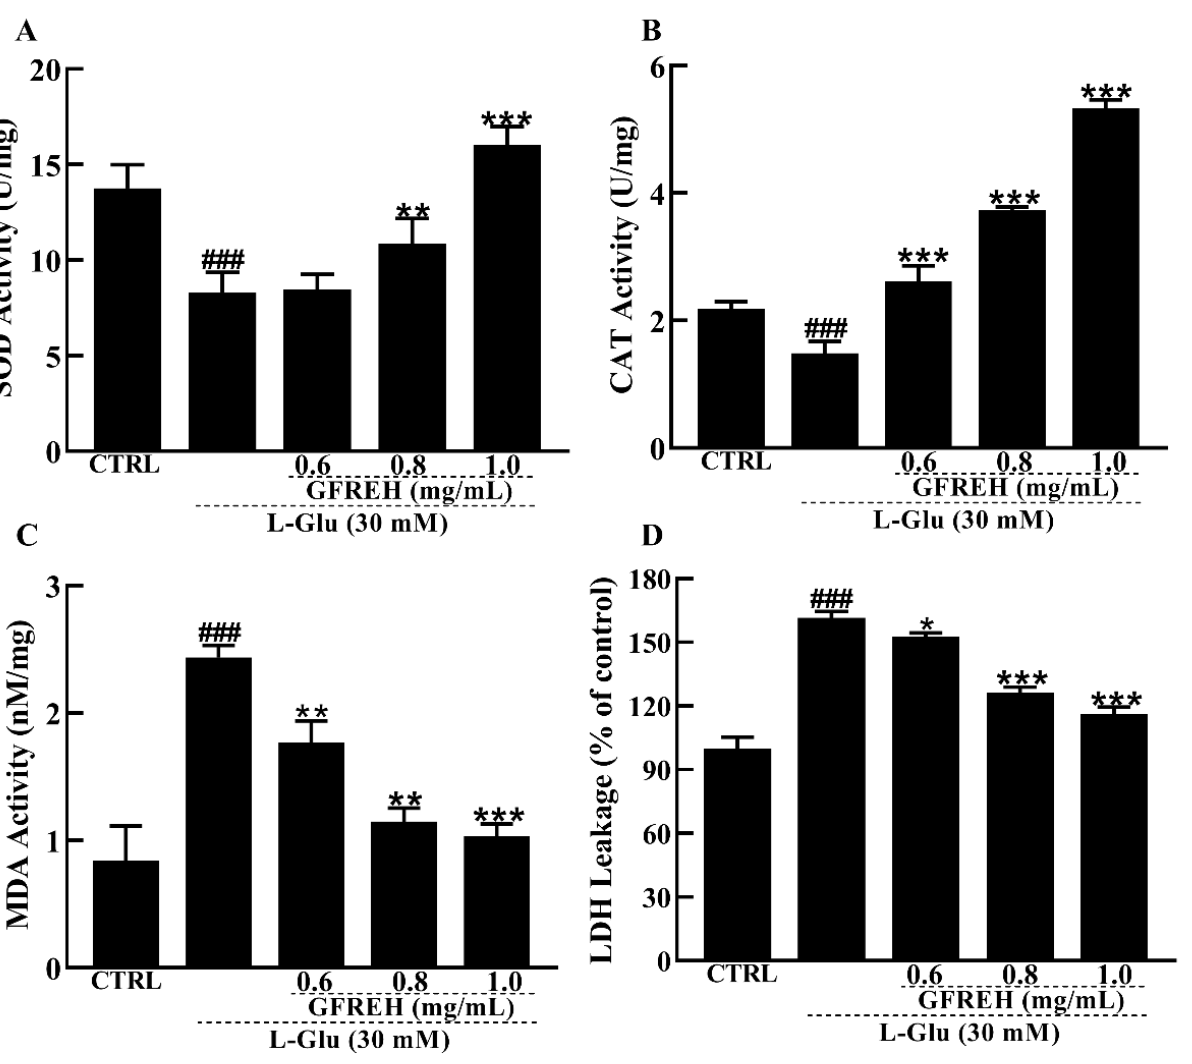
Figure 7. Effect of GFREH antioxidative enzymes in SH-SY5Y cells. The ( A ) SOD activity and ( B ) CAT activity induced by L-Glu were significantly increased by pretreatment with GFREH. The ( C ) MDA levels and ( D ) LDH release levels induced by L-Glu were significantly decreased by pretreatment with GFREH (n = 5). The data are presented as the mean value ± SD. ### p < 0.001 vs. CTRL, * p < 0.05, ** p < 0.01, *** p < 0.001 vs. L-Glu-treated cells.